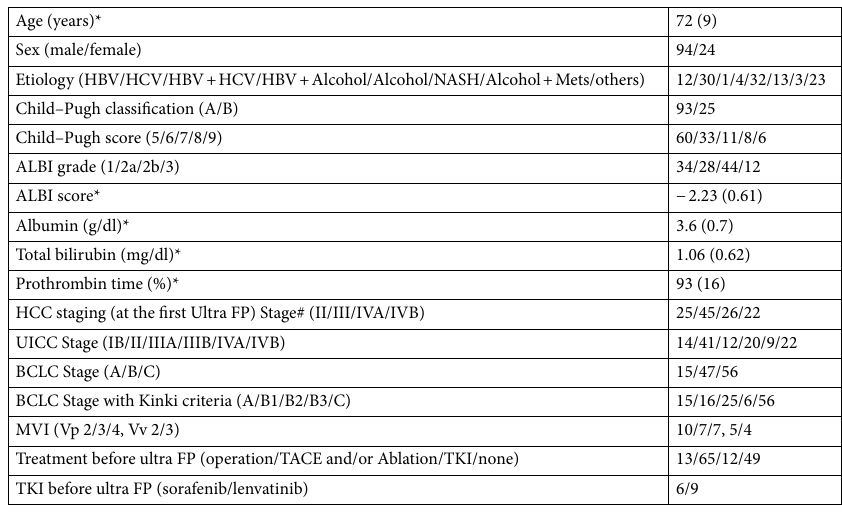
Table 1. Baseline characteristics. UICC Union for International Cancer Control staging, BCLC Barcelona clinic liver cancer, MVI macroscopic vascular invasion, TKI tyrosine kinase inhibitor. *Mean(SD) #general rules for the clinical and pathological study of primary liver cancer staging.